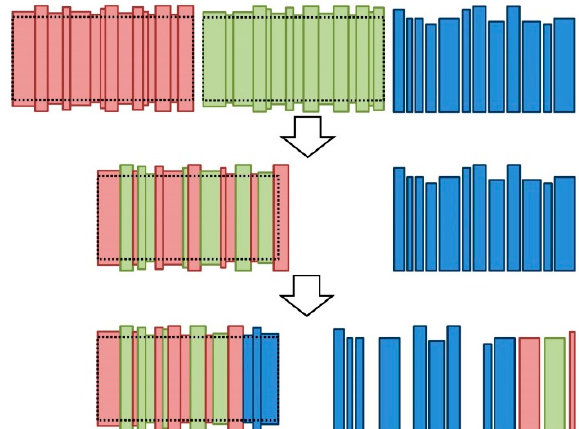
Figure 5. Procedure for applying the external crossing operator to two bodies, which are represented with red and green staves. First, staves for a new body are chosen from the staves of the two bodies randomly. Second, the width requirements of a body barrel are checked and, if these requirements are not satisfied, the mutation operator is applied to build a valid body using idle staves. The number of staves that are represented in this figure is lower than the typical number in a real body (approximately 30) to improve the